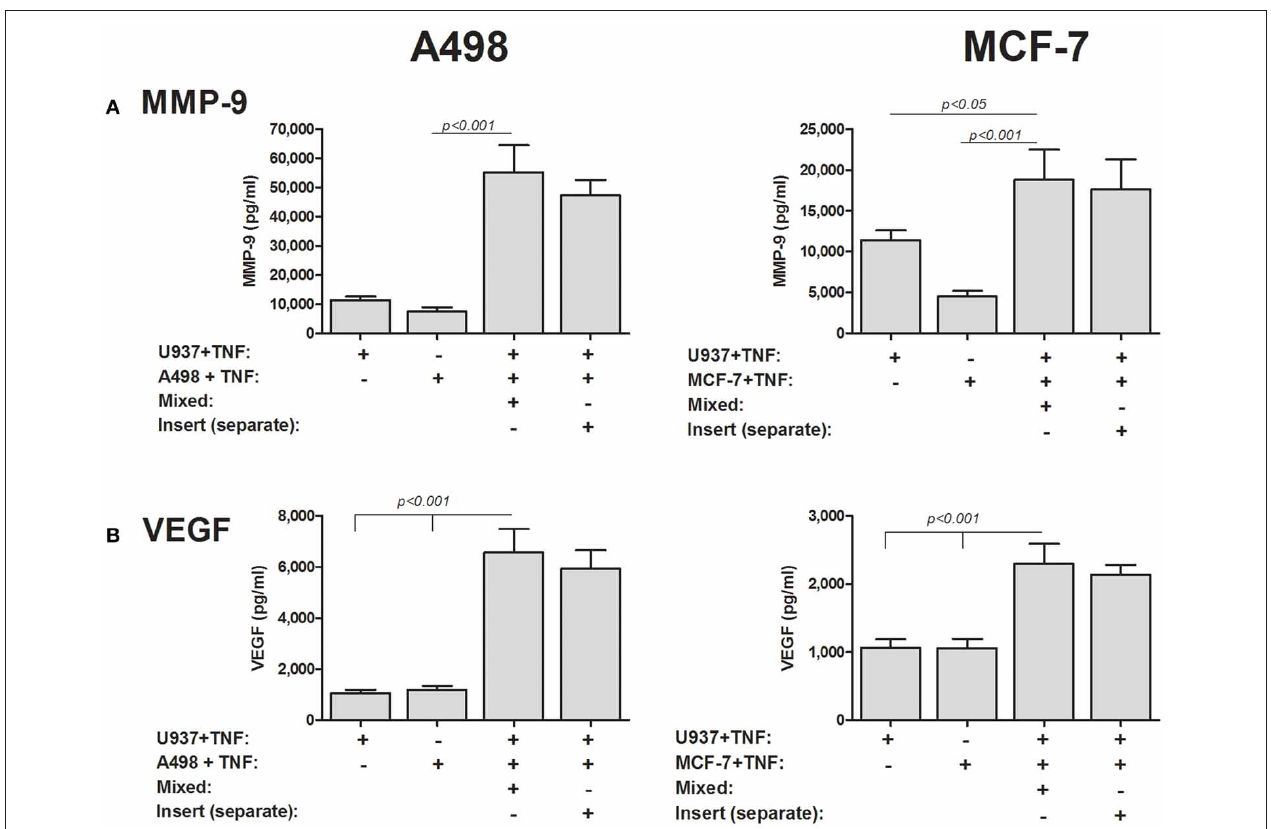
contact was allowed, or in inserts with a small pore size (0.3 μ m) that precluded cell migration and cell–cell contact. Concentrations of (A) MMP-9 and (B) VEGF were determined by ELISA ( n =